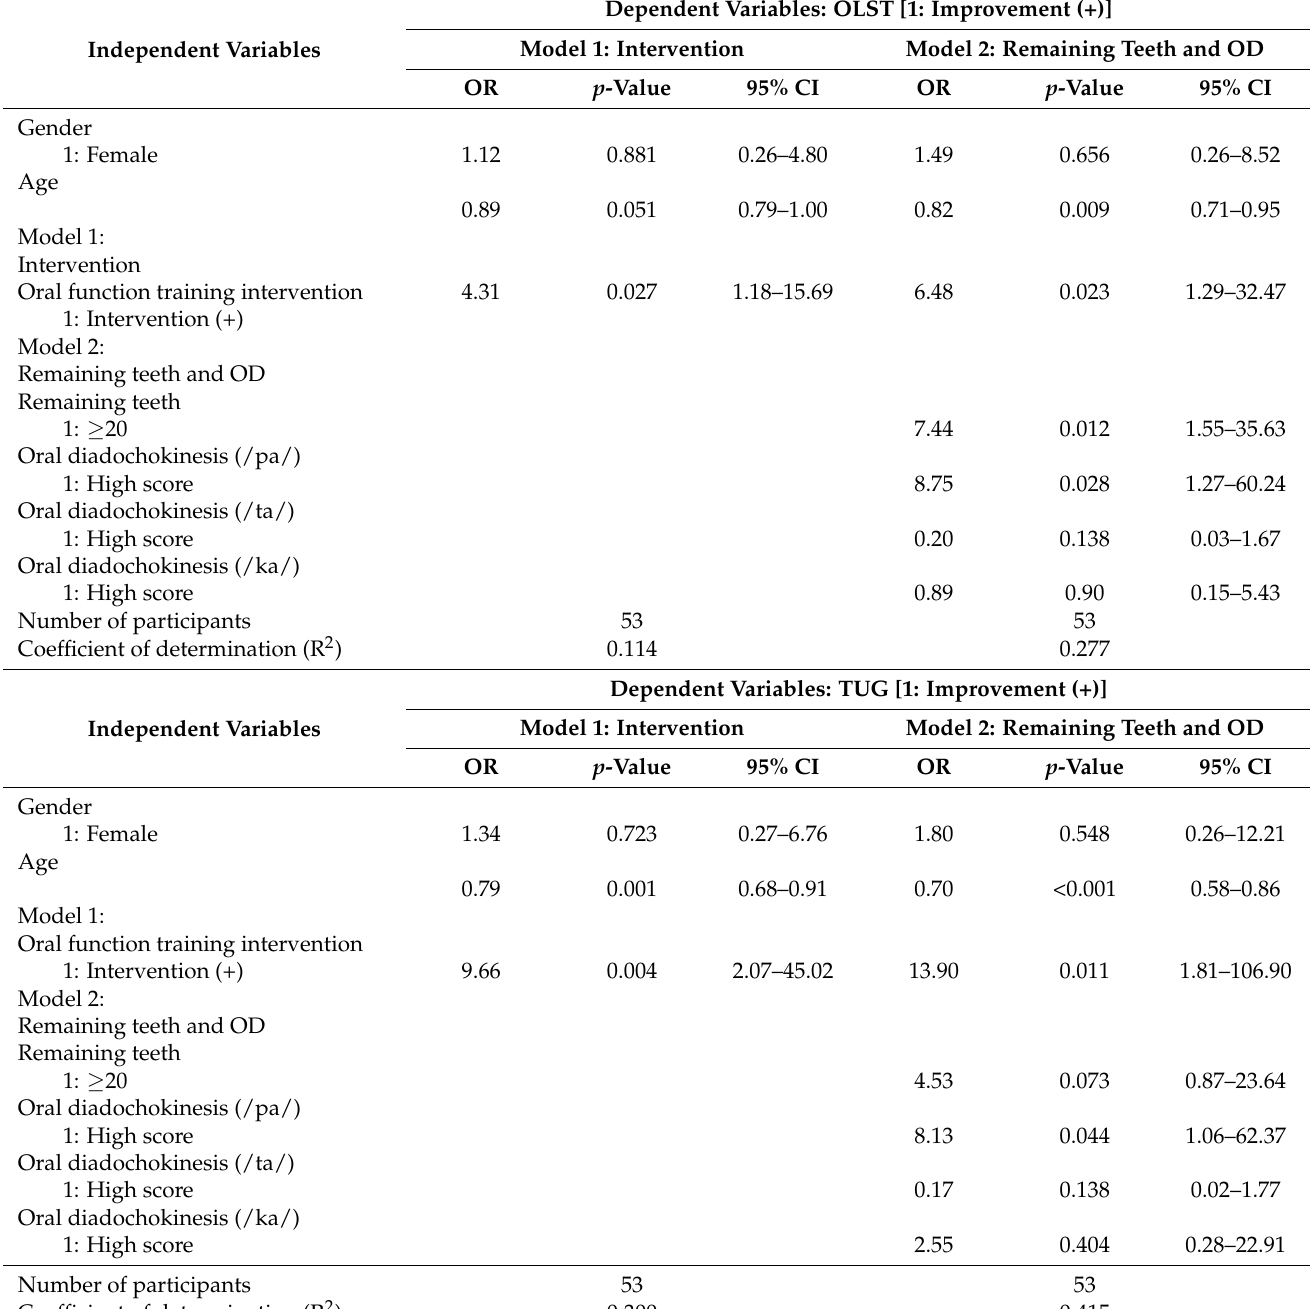
Table 5. Logistic regression analysis of each physical fitness